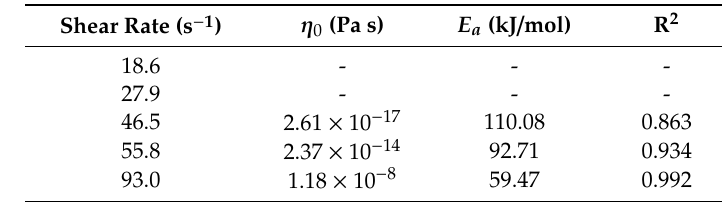
Table 5. Parameters of the Arrhenius equation of oleoresin extracted by SC-CO 2 from the microalga Haematococcus pluvialis at high temperatures (30–60 ◦